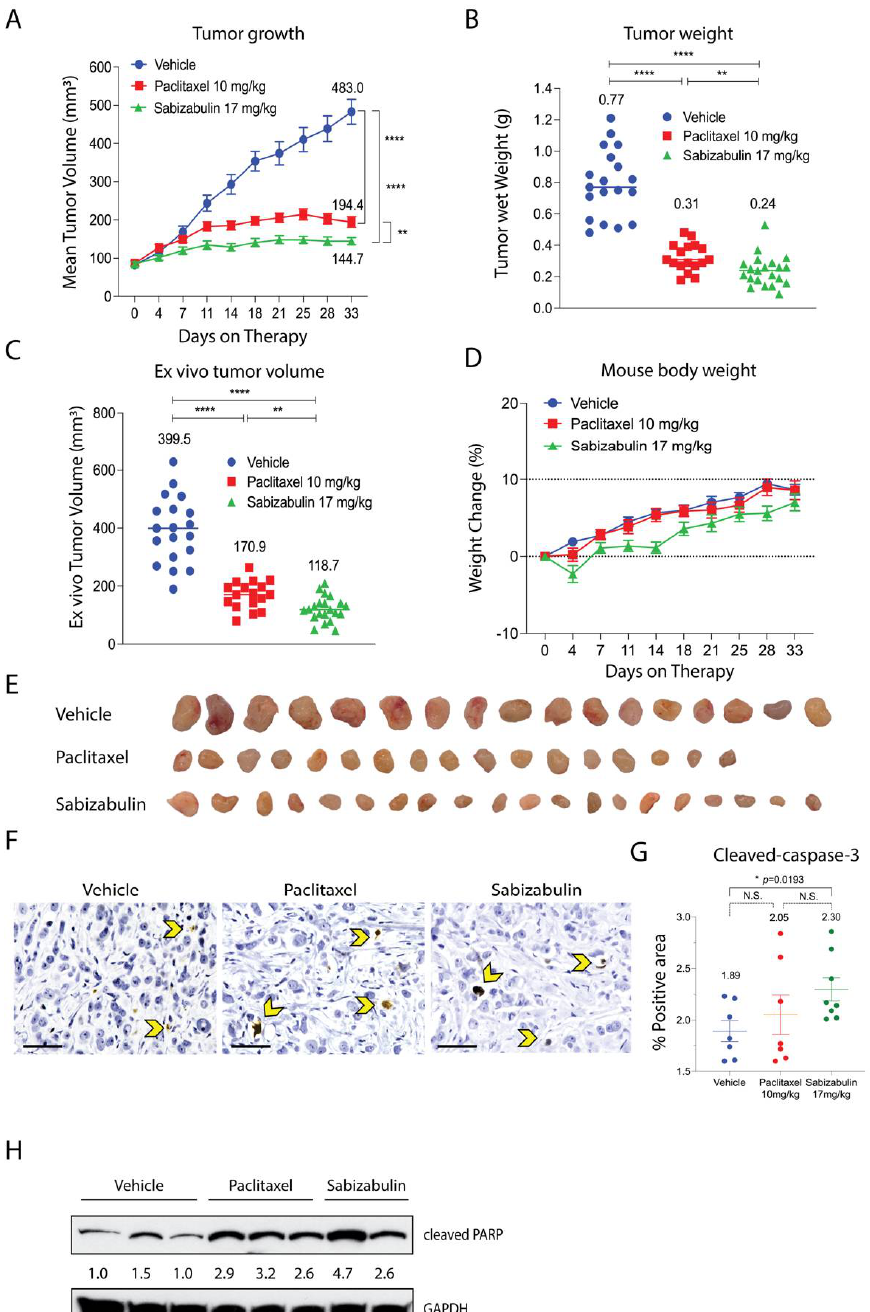
Figure 4. Sabizabulin inhibits tumor growth and induces apoptosis in orthotopic BT474 xenografts. ( A ) Mean tumor volume (mm 3 ) was measured over the course of treatments (days on therapy): vehicle (IP, 3 × /week, n = 19 total tumors), paclitaxel (10 mg/kg, IP, 3 × /week, n = 17 total tumors), or sabizabulin (17 mg/kg, PO, 3 × /week, n = 21 total tumors). Mean tumor wet weight ( B ) and mean ex vivo measured tumor volume ( C ) are shown at experiment endpoint (33 days). ( A – C ) The mean values are also indicated above each treatment group. All p -values were calculated as pairwise comparisons relative to the vehicle control group at 33 days; ** p < 0.01; **** p < 0.001. ( D ) Mean percent (%) change in body weight over time for vehicle (n = 11 mice), paclitaxel (n = 11 mice), or sabizabulin (n = 12 mice); dashed lines indicate initial body weight (y = 0) with a − 10%